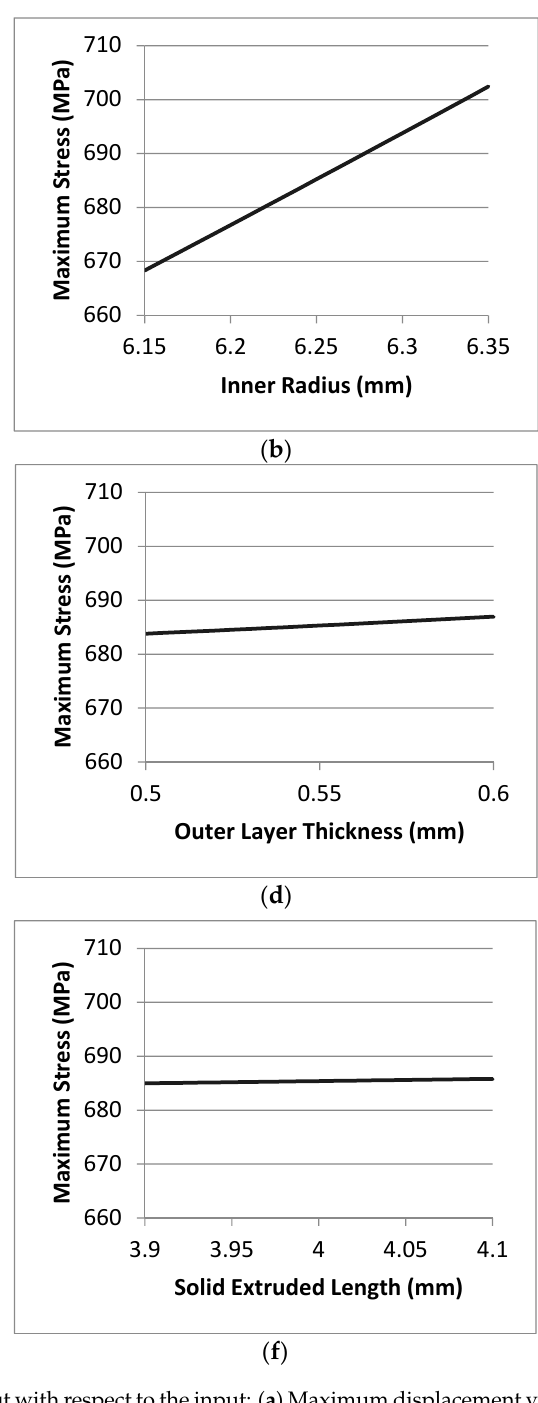
Table 4. The relative effects of the input parameters on the output responses.